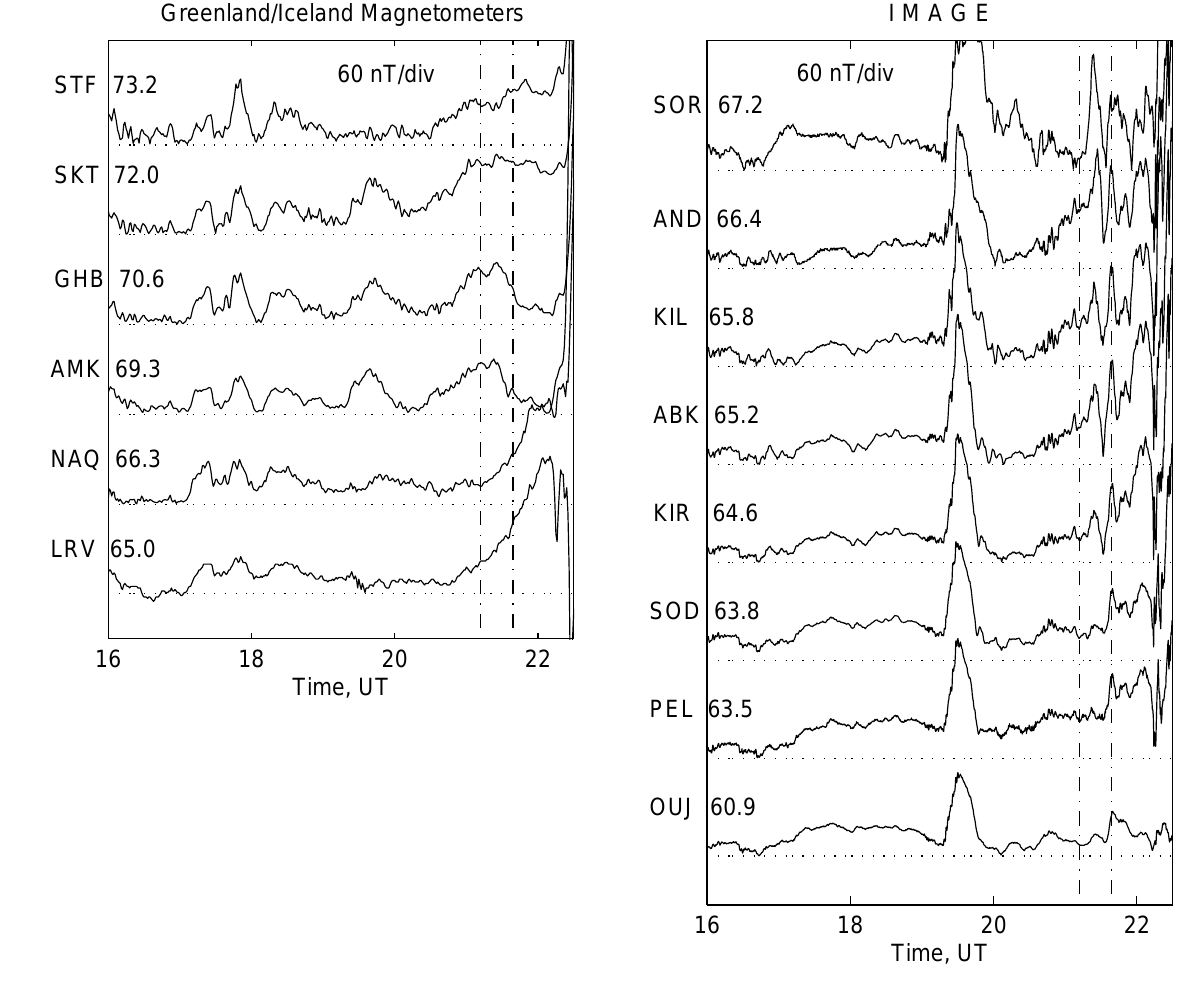
Fig. 2. Horizontal magnetic disturbances (magnitudes) measured by the magnetometers shown in Fig. 1 The vertical dash-dotted lines show the considered interval of echo